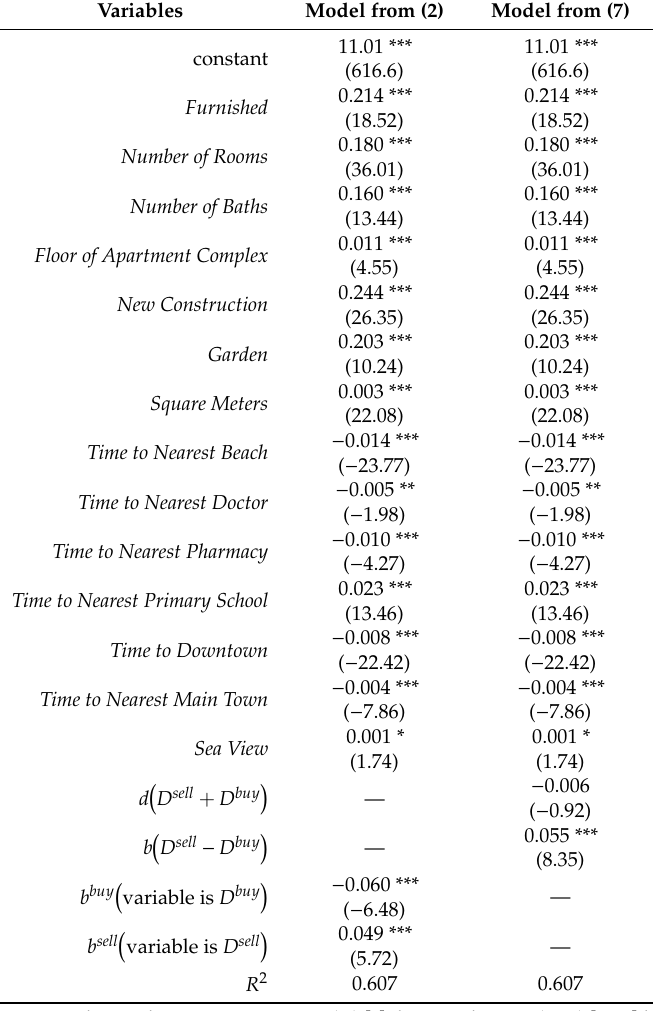
Table 1. Bargaining power